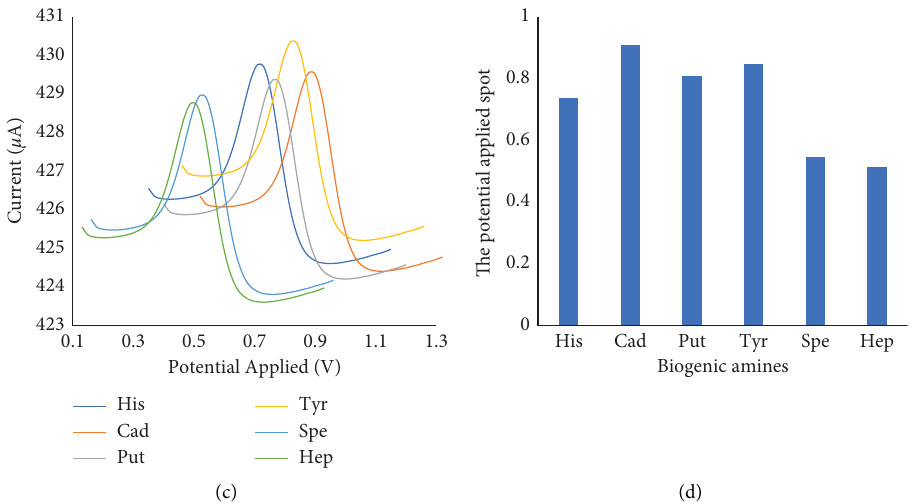
Figure 5: Te DPV voltammograms of histamine in fsh mackerel using PBS (100mmol · L − 1 ) at pH 7 on (a) MIP/SPE/PU/LiClO NIP/SPE/PU/LiClO 4 . (c) Te DPV voltammograms of biogenic amines using PBS (100mmol · L − 1 ) at pH 7 on MIP/SPE/PU/LiClO 4 . (d) Te selectivity plot of biogenic amines against potential applied